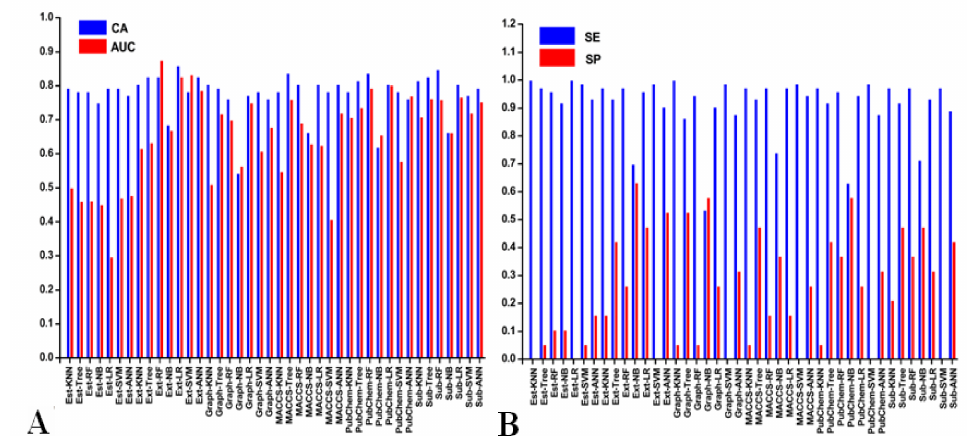
Figure 2. Performance of 10-fold cross-validation for training set in 42 classification models. ( A ) CA, AUC ( B ) SE, and SP, which are the classification accuracy; the area under the ROC curve, sensitivity, and specificity,